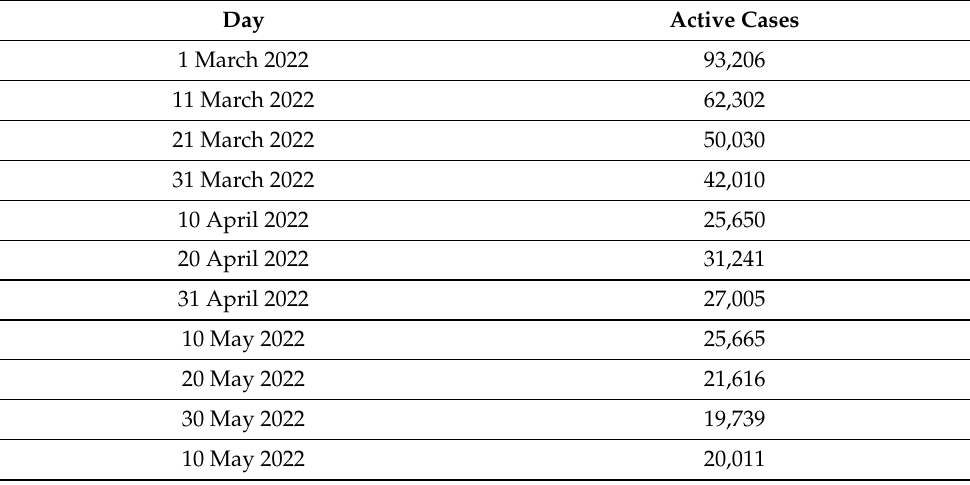
Table 3. Number of active cases between 1 March 2022 and 10 June